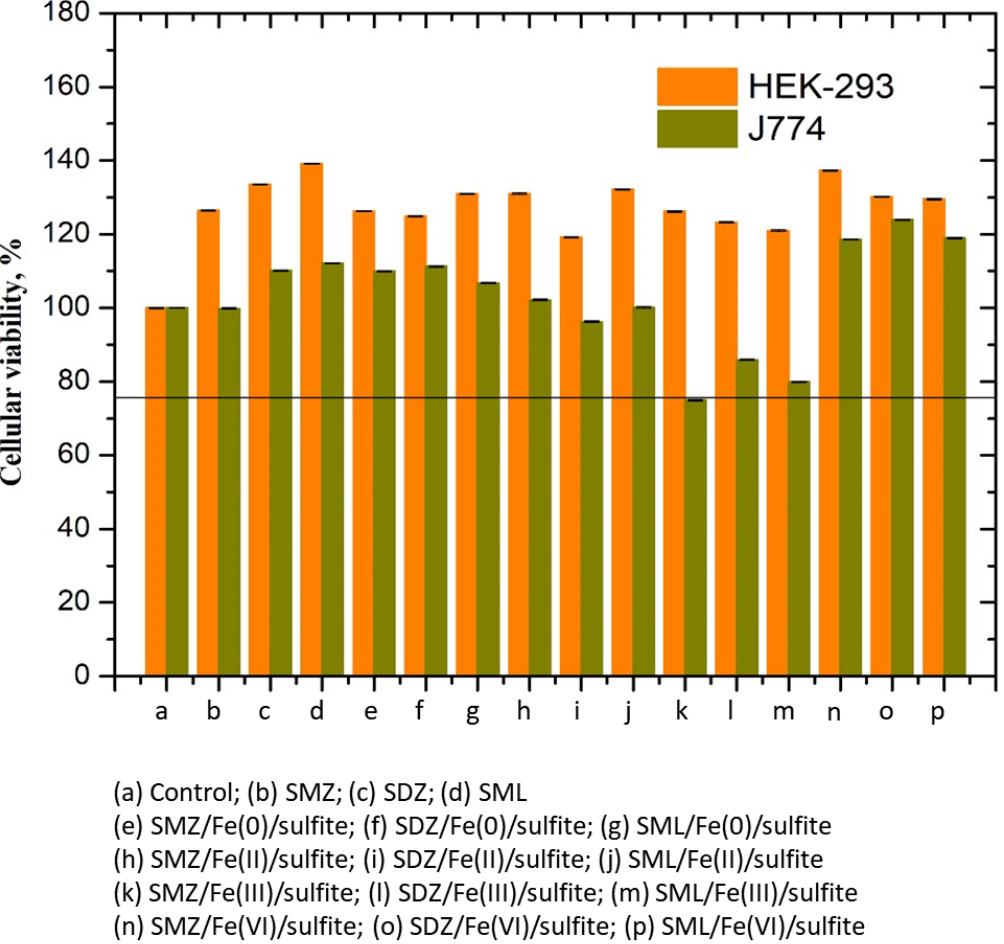
Figure 6. Cellular viability (%) of HEK293 and J774 of SAs (sulfamethazine (SMZ), sulfadiazine (SDZ), and sulfamethizole (SML)) by an iron-based/sulfite system. [SAs] = 5.389 × 10 −5 M, [Fe(0–VI)] = 1.79 × 10 −2 M, [sulfite] = 5.0 × 10 −3 M, pH 3, T = 298 K, time = 60 min.